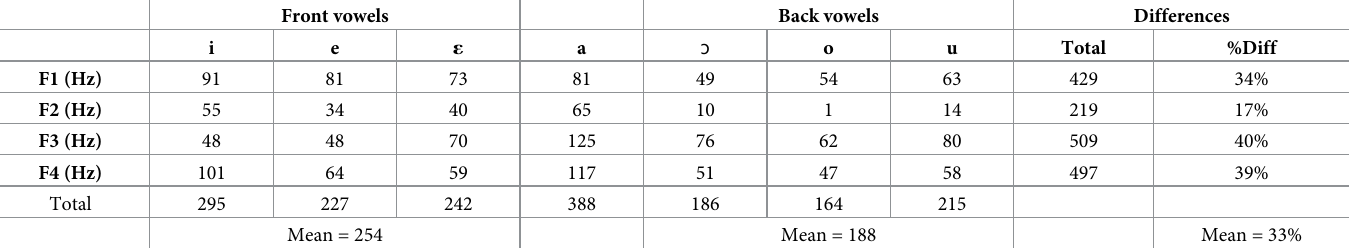
Table 2. Number of significant differences (p < 0.05/2) among non-genetically related speakers for comparisons considering both stressed and unstressed vowels. Two-tailed test with Bonferroni correction. Front